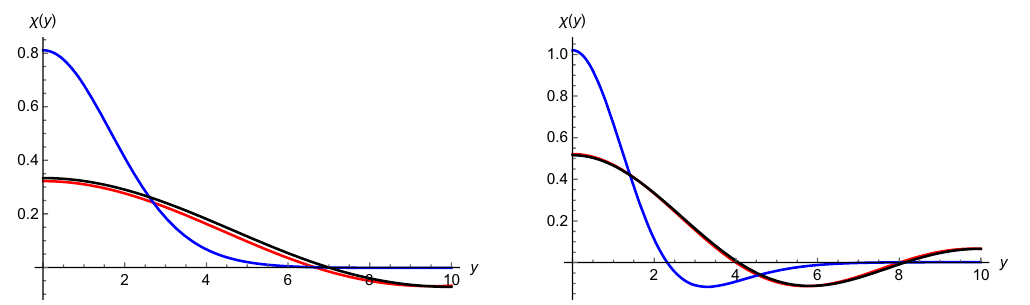
Figure 8 . Eigenfunction of the numerical solution (blue) and analytical approximation (red) of the (cid:12)rst (left) and second (right) radial mode.